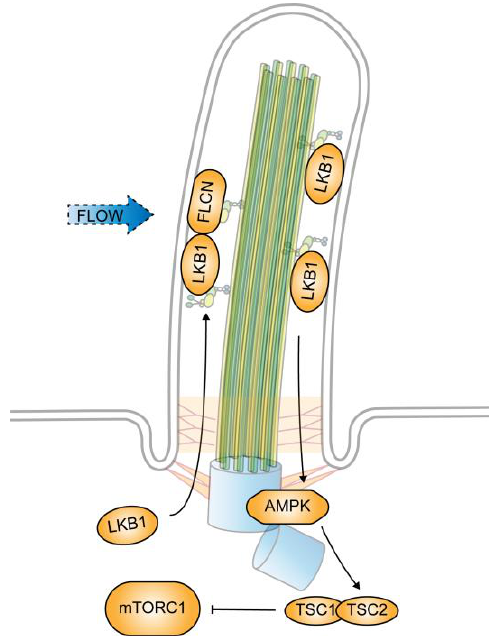
Figure 2. Cilium-dependent regulation of mechanistic target of rapamycin complex 1 (mTORC1) by flow stress. mTORC1 activity decreases in response to flow stress that deflects primary cilia. The decrease is caused by FLCN-mediated ciliary accumulation of liver kinase B1 (LKB1). The accumulated LKB1 activates AMP-activated protein kinase (AMPK) localized at the basal body, which in turn phosphorylates Tsc2, leading to mTORC1 downregulation.